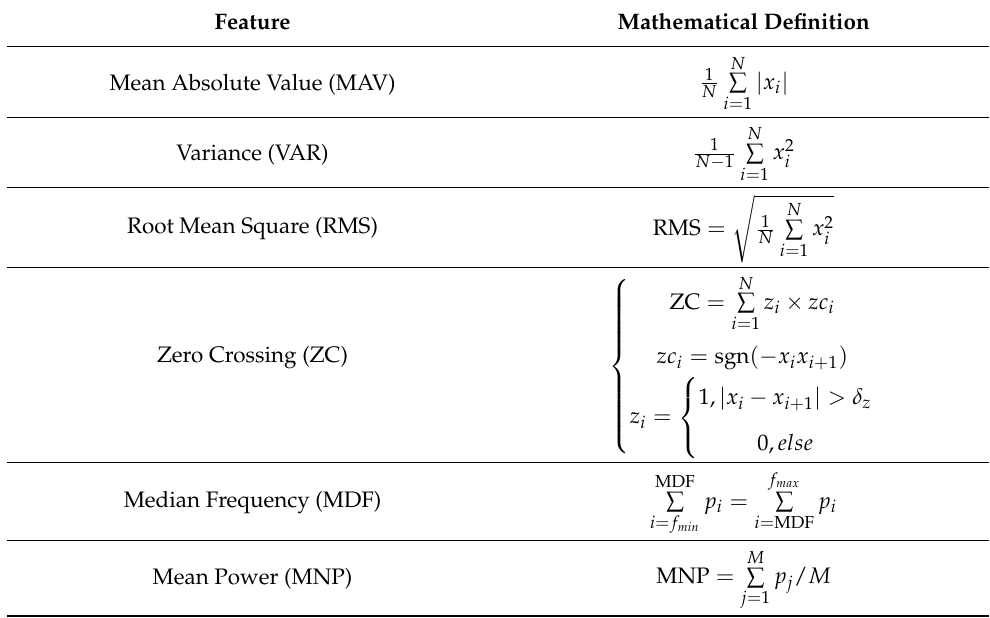
Table 2. Time and frequency domain features expression of